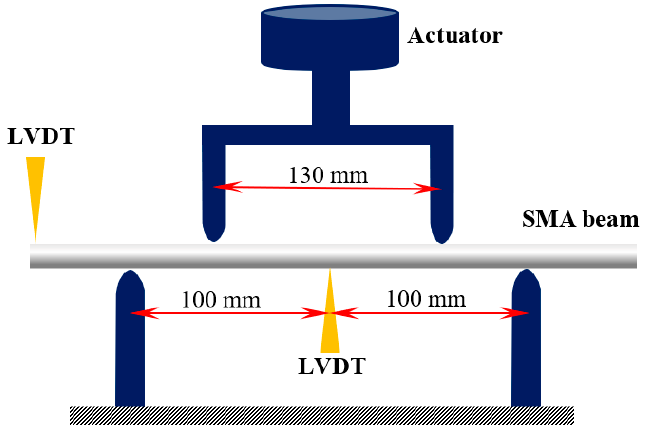
Figure 19. Dimension and schematically experimental setup for four-point bending tests.